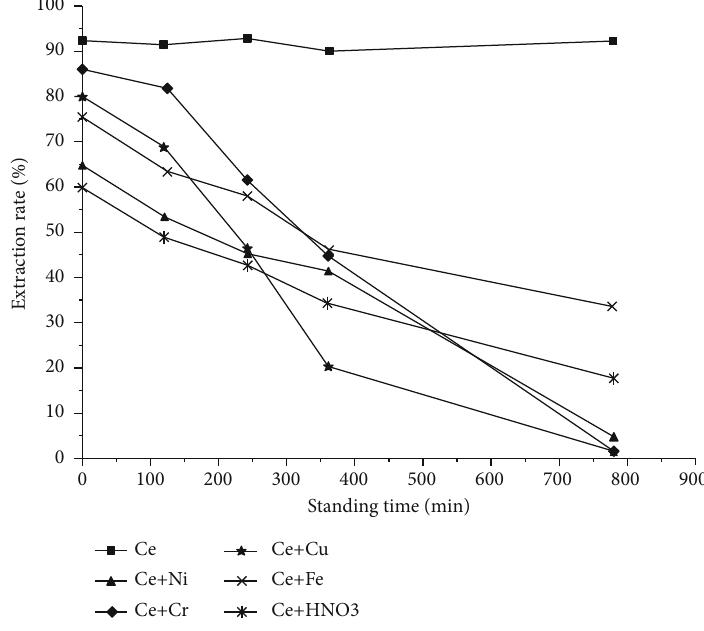
Figure 7: Single factor test